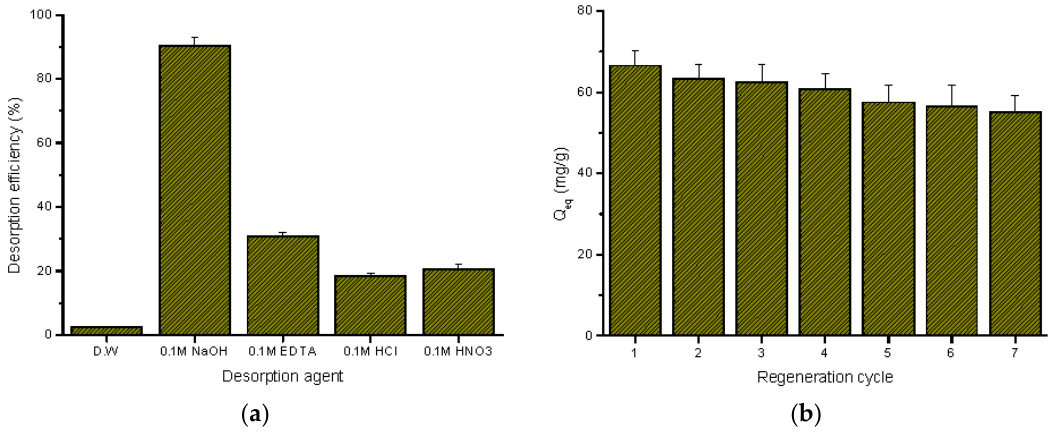
Figure 12. Effect of desorption agent on desorption efficiency ( a ) and its regeneration adsorption capacity of SS/KL blend beads after each cycle ( b